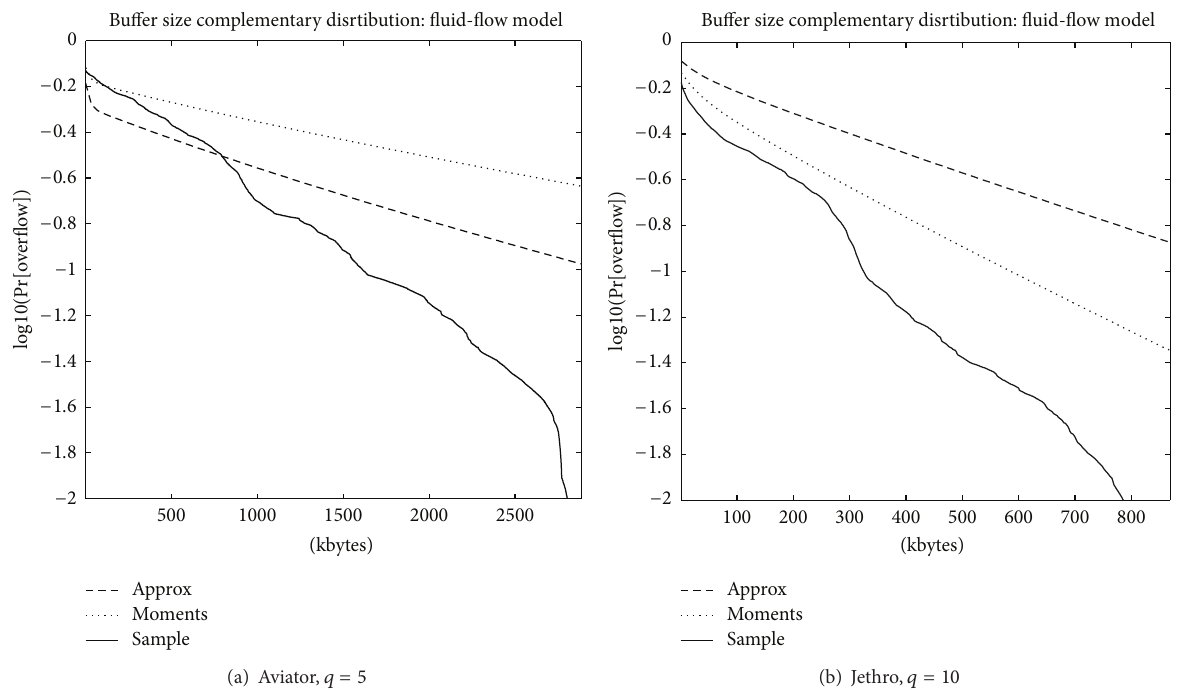
Figure 4: (a) Complementary buffer size distribution; fluid-flow model for Aviator 𝑞 = 5 (b) complementary buffer size distribution; fluid flow-model for Jethro 𝑞 = 10